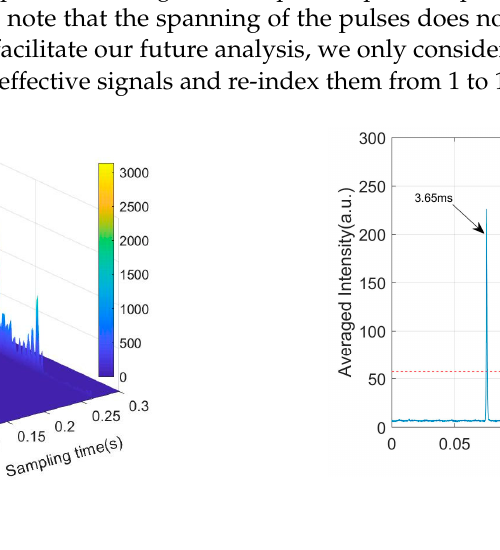
Figure 3. ( a ) Scattered intensity with pixel of CCD and sampling time. ( b ) Temporal signal of averaged intensity 𝐼̅(𝑡) ; red dotted line: threshold to select pulses.